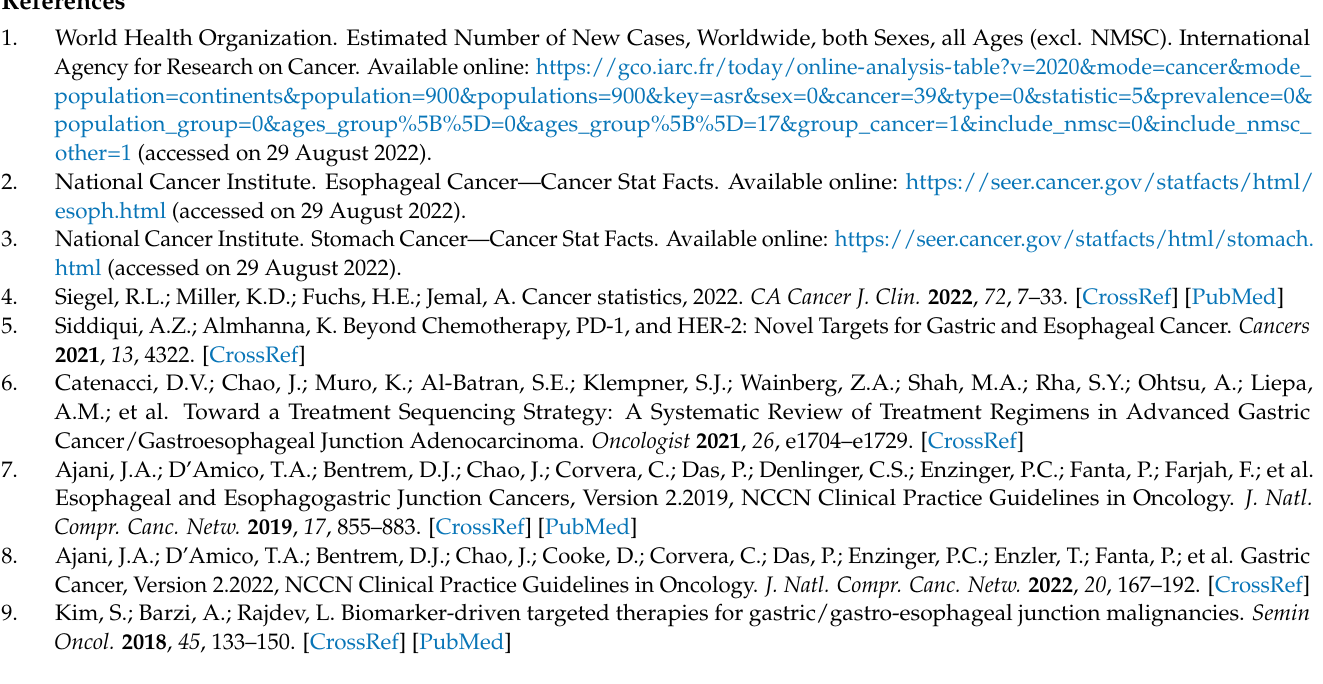
testing rates and results; Figure S3: Sankey diagram for treatment sequences; Table S1: Baseline demographic characteristics by PD-L1 and MMR/MSI testing status; Table S2: Baseline demographic characteristics by HER2 testing status; Table S3: Baseline demographics and testing characteristics by NGS testing status; Table S4: Overall biomarker test counts, tissue collection sites, and assays; Table S5: Details on first two biomarker tests in patients who underwent multiple biomarker tests; Table S6: PD-L1 combined positive scores overall and by primary tumor site; Table S7: Baseline clinical and disease-related characteristics by HER2 testing